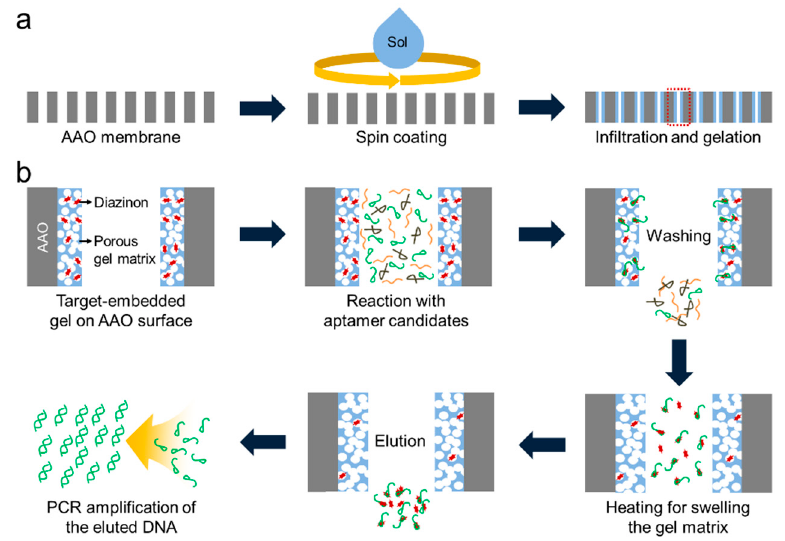
Figure 1. ( a ) Schematic of the procedure for performing the sol-gel coating process on the anodized aluminum oxide (AAO) membrane by spin coating and ( b ) sol-gel nanocolumn-based target pesticide-specific aptamer binding, elution, and polymerase chain reaction (PCR)